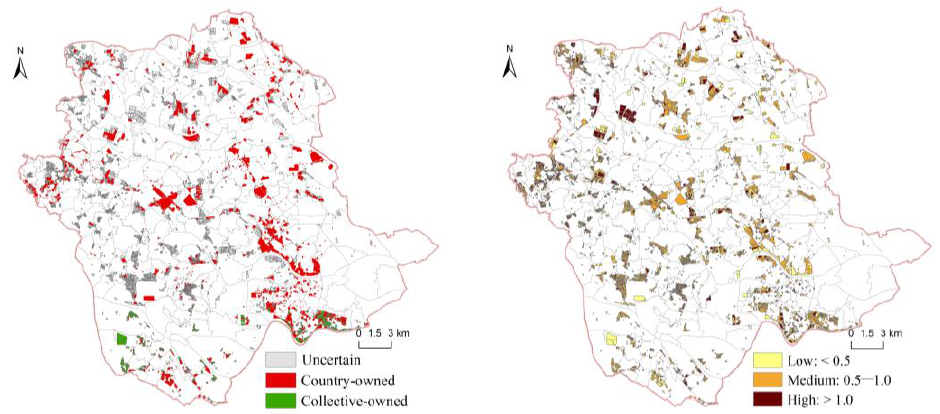
Figure 6. Ownership and plot ratio of rural industrial land in Shunde District (2018).